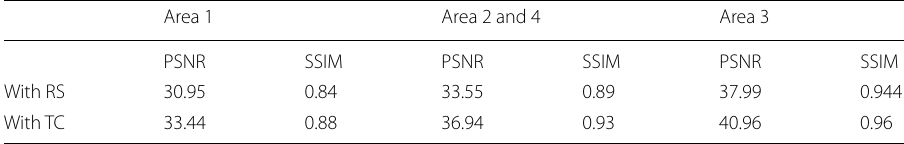
Table 6 Average performance for the House image in terms of PSNR ( dB ) and SSIM